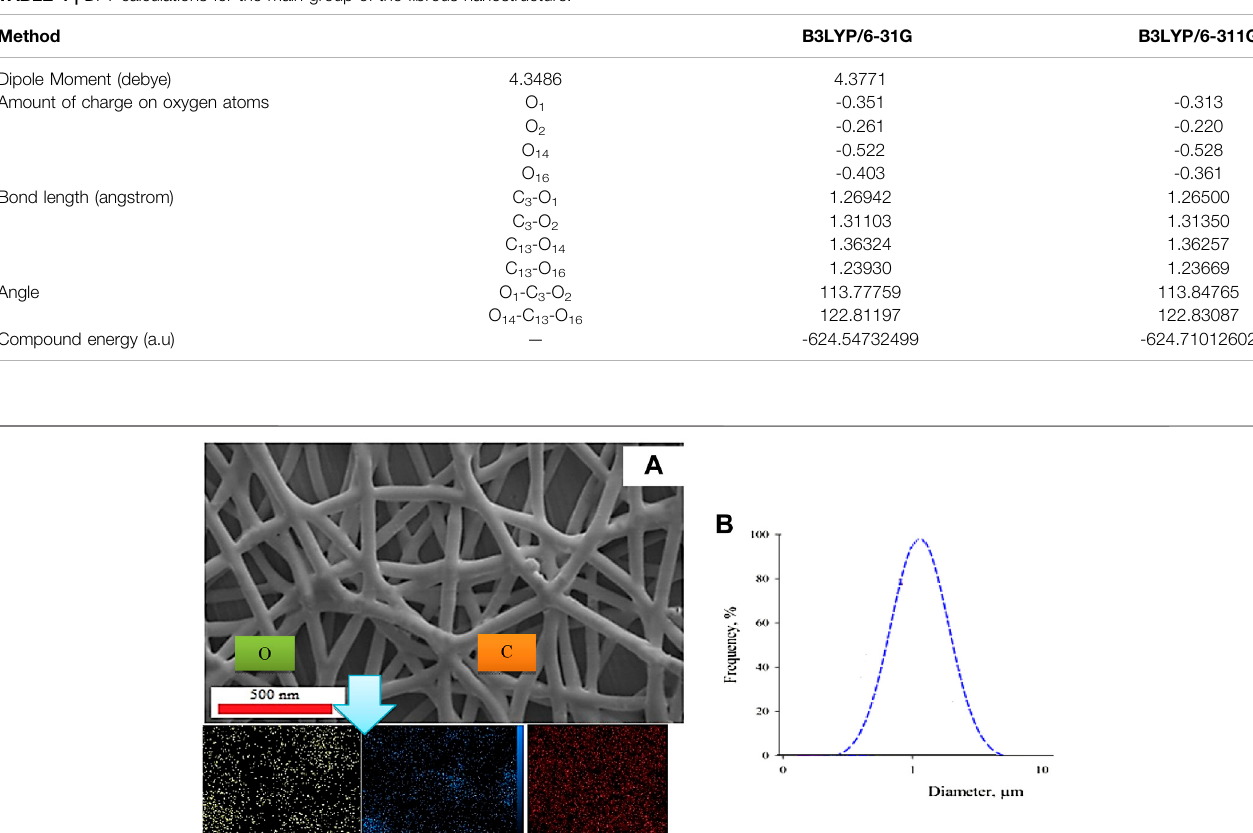
TABLE 4 | DFT calculations for the main group of the fi brous nanostructure.